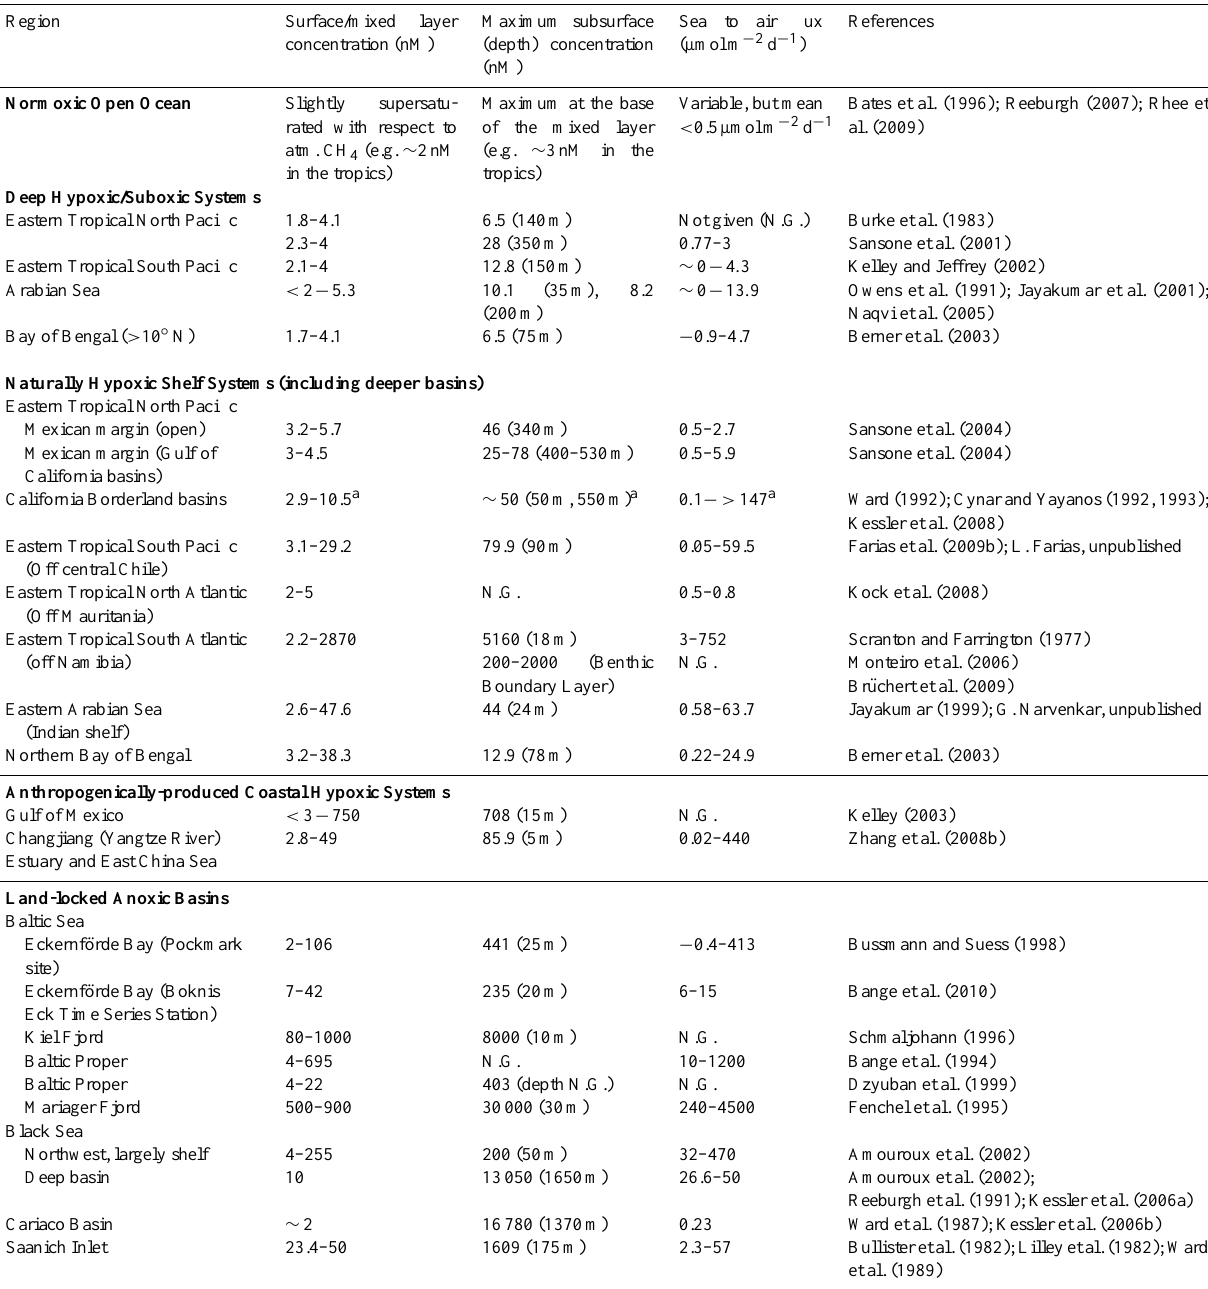
Table 2a. Concentrations and sea-to-air fluxes of CH 4 from major hypoxic/suboxic/anoxic zones.